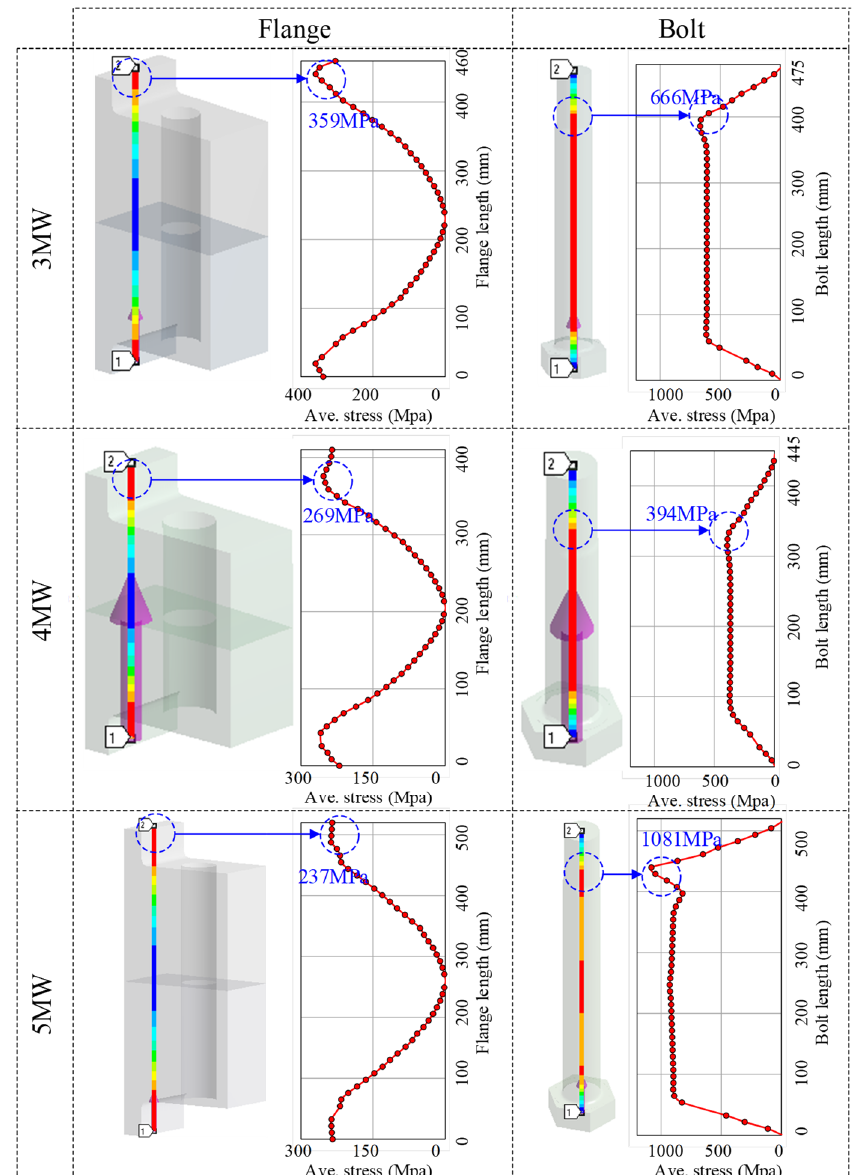
Figure 7. Global stress in the flange joints.